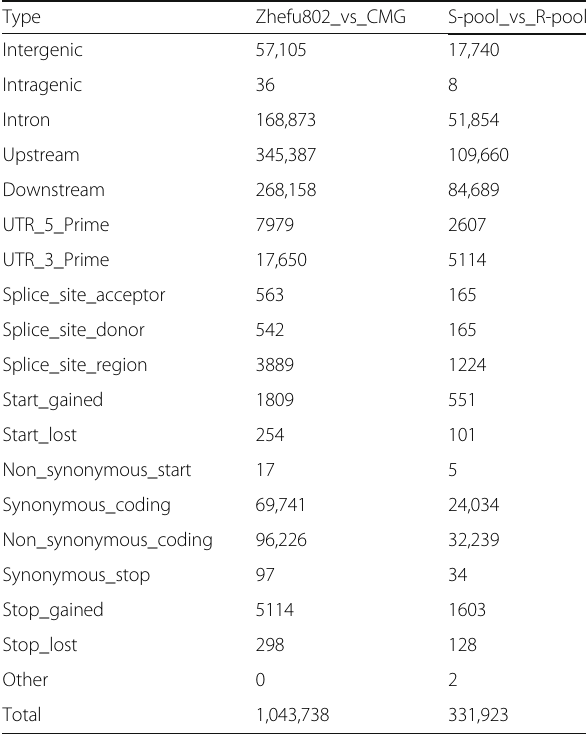
Table 2 The distribution of detected SNPs between both parents Zhefu802 and CMG and between the two extreme